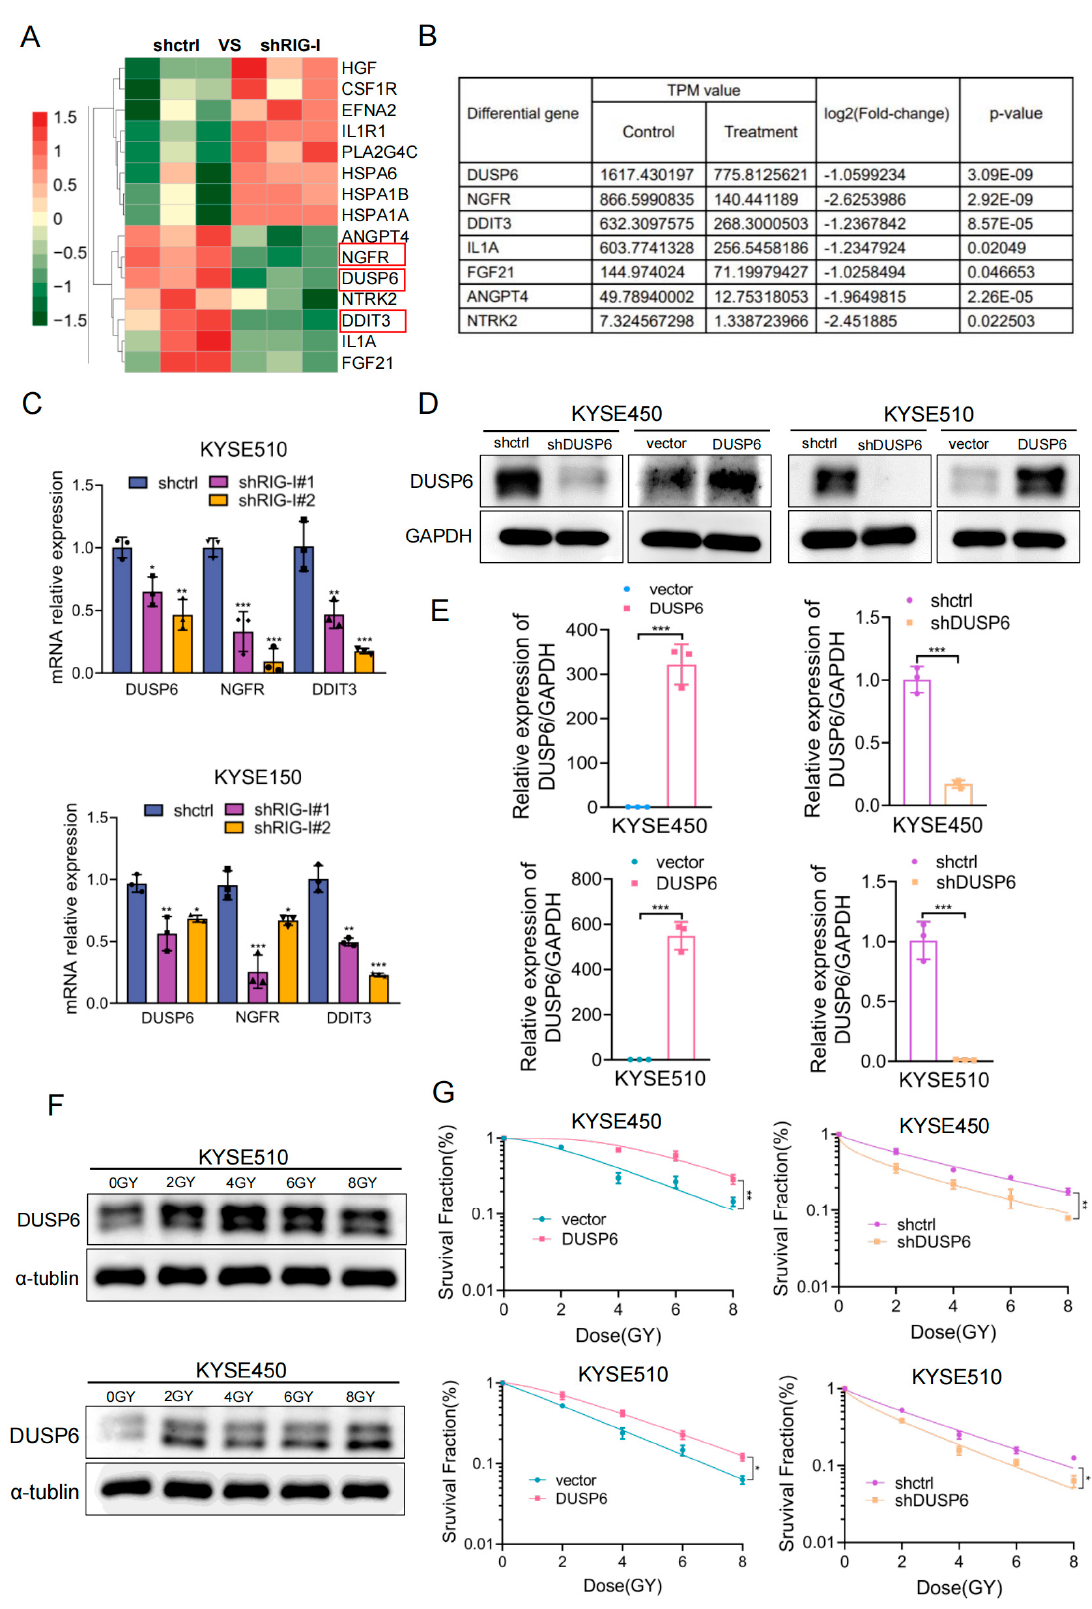
Figure 4. Effect of overexpression and silencing of downstream differential gene DUSP6 on radioresistance of ESCC cells. ( A ) Differentially expressed genes in the MAPK signaling